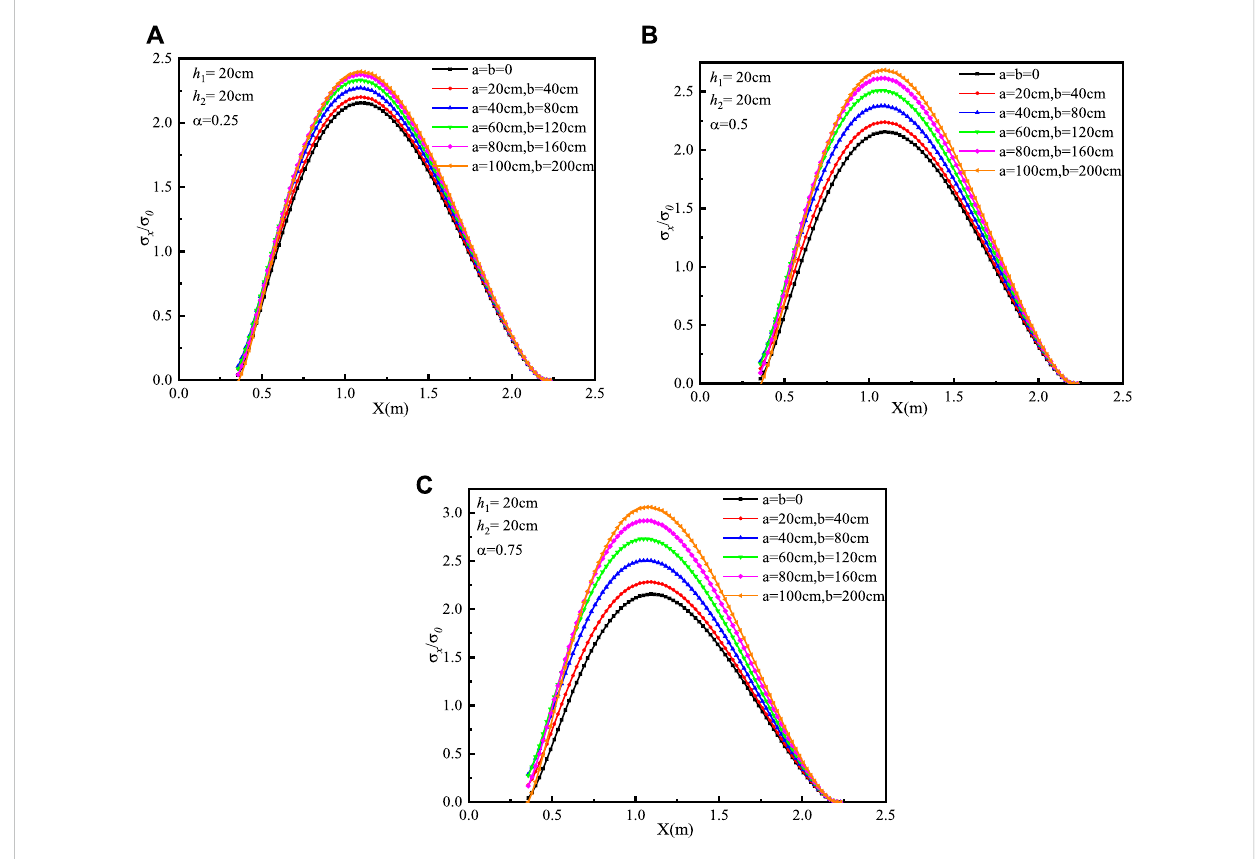
FIGURE 7 Dimensionless tensile stress distribution of the pavement using the FEM with h 1 = h 2 = 20 cm: (A) α = 0.25, (B) α = 0.5, and (C) α =